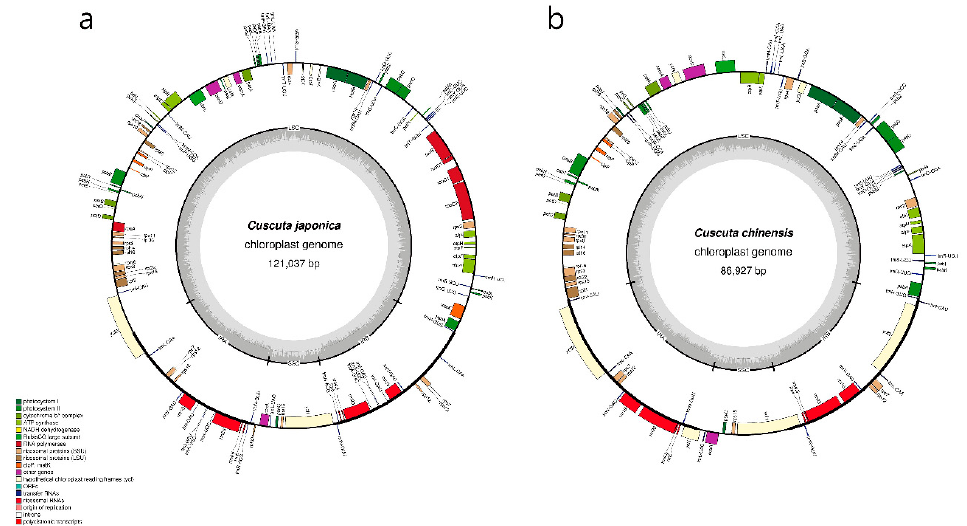
Figure 2. Chloroplast genome maps of C. japonica and C. chinensis . ( a ) C. japonica . ( b ) C. chinensis . Genes drawn inside the circle are transcribed clockwise, and those outside the circle are transcribed counterclockwise. Dark grey shading in the inner circle represents the GC content.